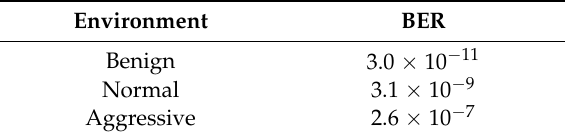
Table 1. Bit Error Rate (BER) measurements in Controller Area Network (CAN)